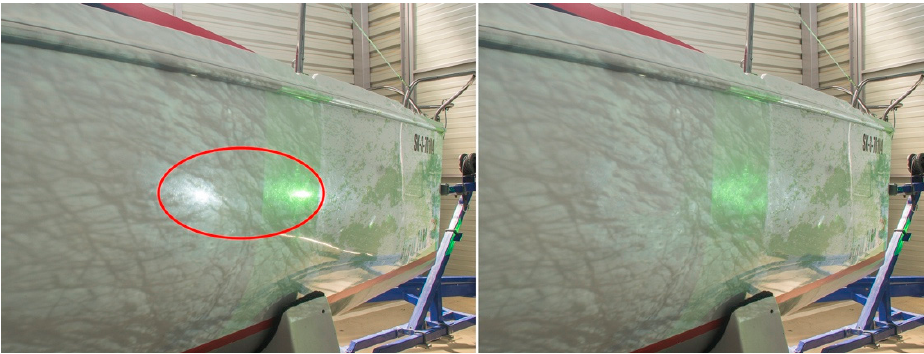
Figure 13. Left—reflections from oblique imaging; right—partial elimination using a polarisation filter.